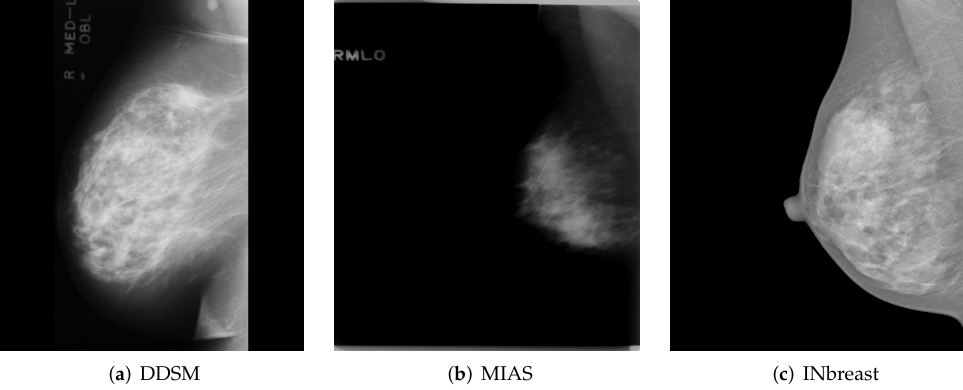
Figure 1. MLO views of the right breast from publicly available datasets. ( a , b ) A sample from the DDSM [13] and MIAS [14] dataset, respectively. ( c ) A sample from INbreast [15]. Reprinted/adapted with permissions from [13–15].